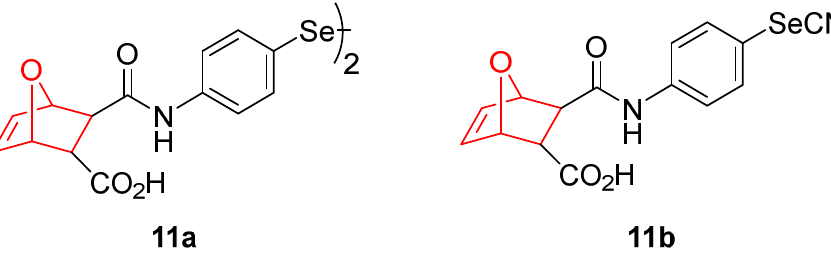
Figure 11. Selenium containing oxabicyclic derivatives